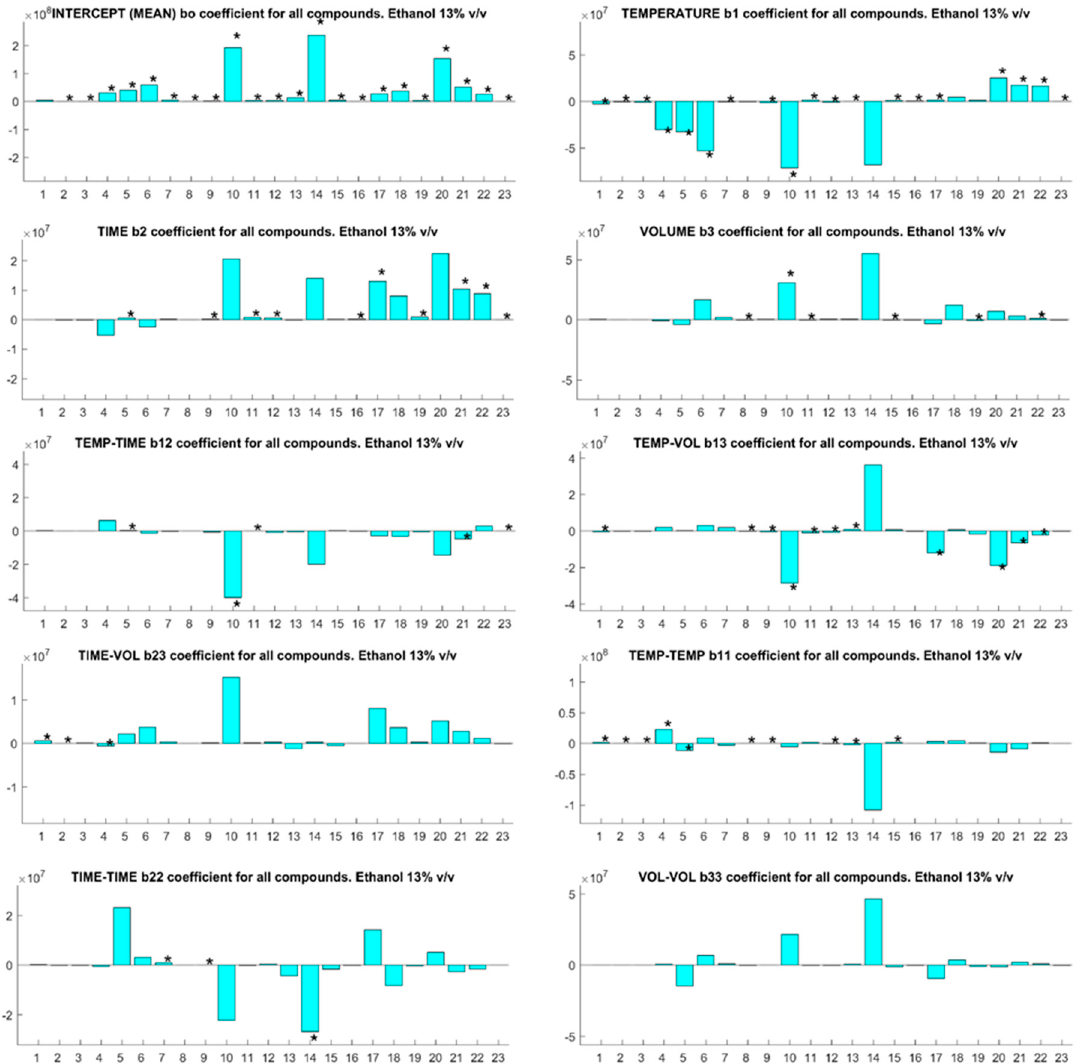
Figure 3. The b -coefficients (absolute units) for SPME optimization parameters for 23 compounds with an ethanol concentration of 13% v / v . Significant coefficients for specific compounds are indicated with an asterisk (*). Compound identification is cross-referenced to the numbered compounds in Table 1.